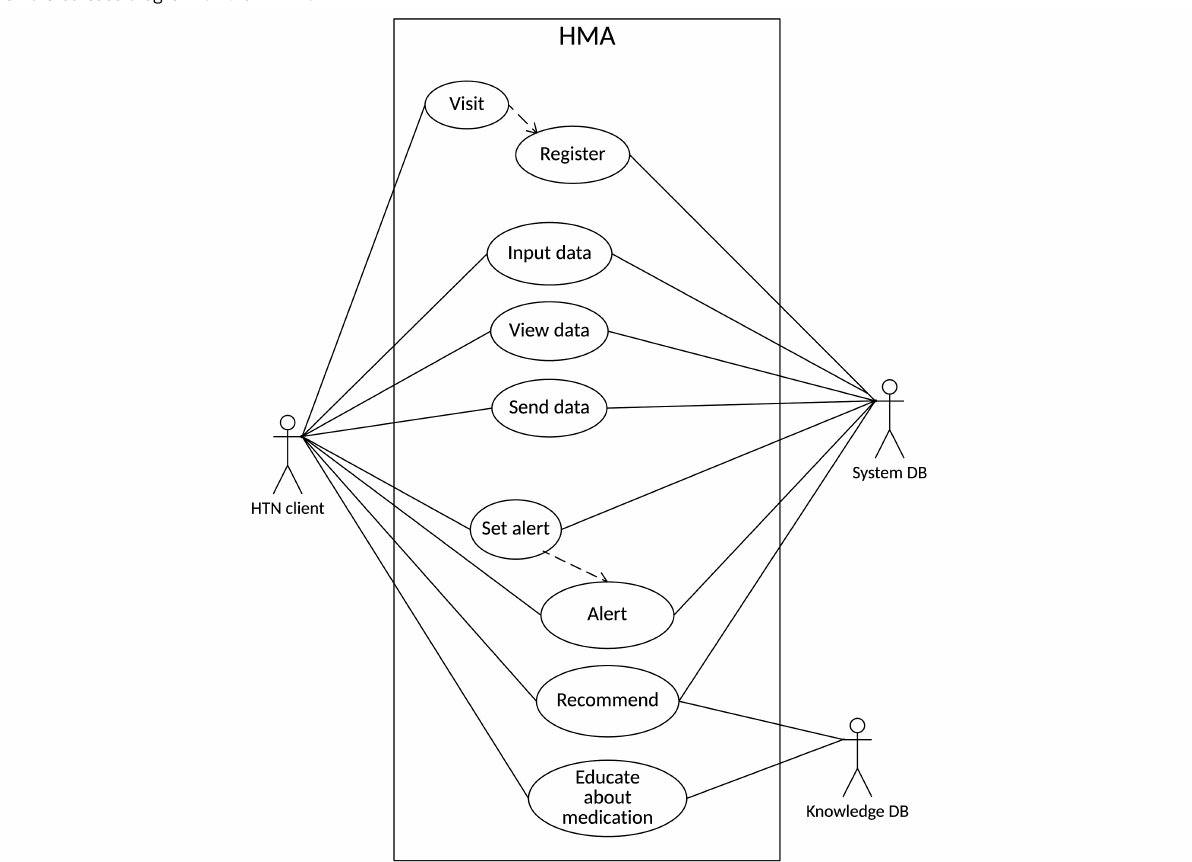
Figure 4. Use-case diagram of the